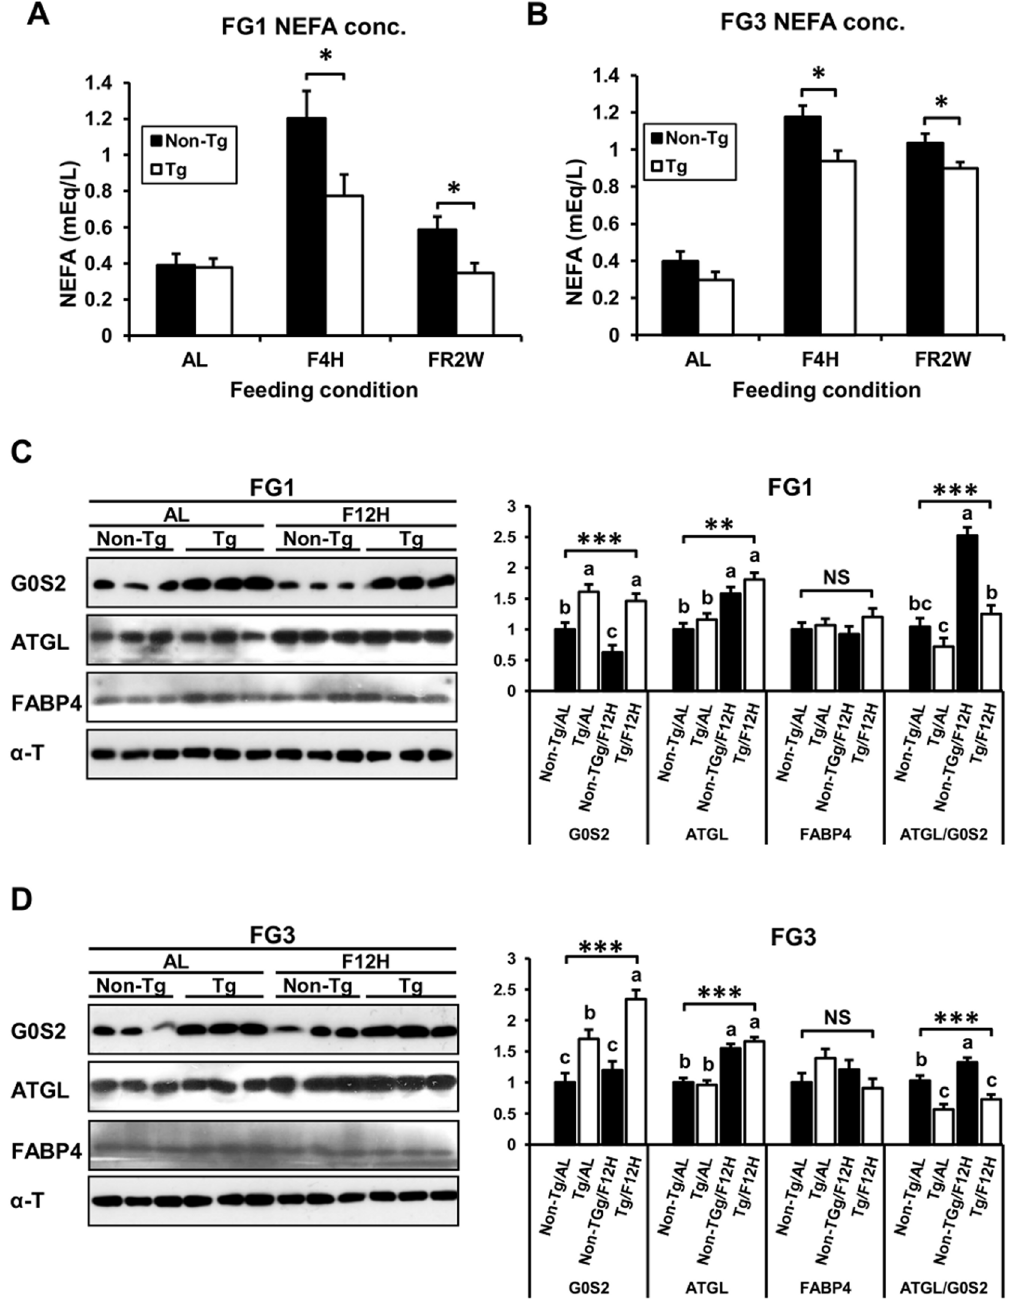
Figure 5. Blood NEFA levels and the expression of G0S2 and ATGL in fat tissues in different feeding conditions. ( A ) and (B) The levels of NEFA in serum were significantly lower in transgenic quail than in non-transgenic quail under the short-term fasting and feed restriction conditions ( n $ 5). AL: ad libitum , F4H: fasting for 4 hours, and FR2W: feed restriction for 2 weeks. (C) and (D) The expression of G0S2, ATGL, and FABP4 in fat tissues depending on feeding conditions, ad libitum (AL) vs. fasting for 12 hours (F12H). G0S2 was continuously higher in transgenic quail than non- transgenic quail. The expression of ATGL was higher in fasting condition in both transgenic and non-transgenic quail. The ratio of ATGL to G0S2 was highest in non-transgenic quail under the fasting condition. The expression of FABP4 was not significantly variable regardless of feeding condition. Values are represented as mean 6 SEM. *, **, and *** indicate significance levels of P , 0.05, 0.01, and 0.001, respectively. NS means non-significant.